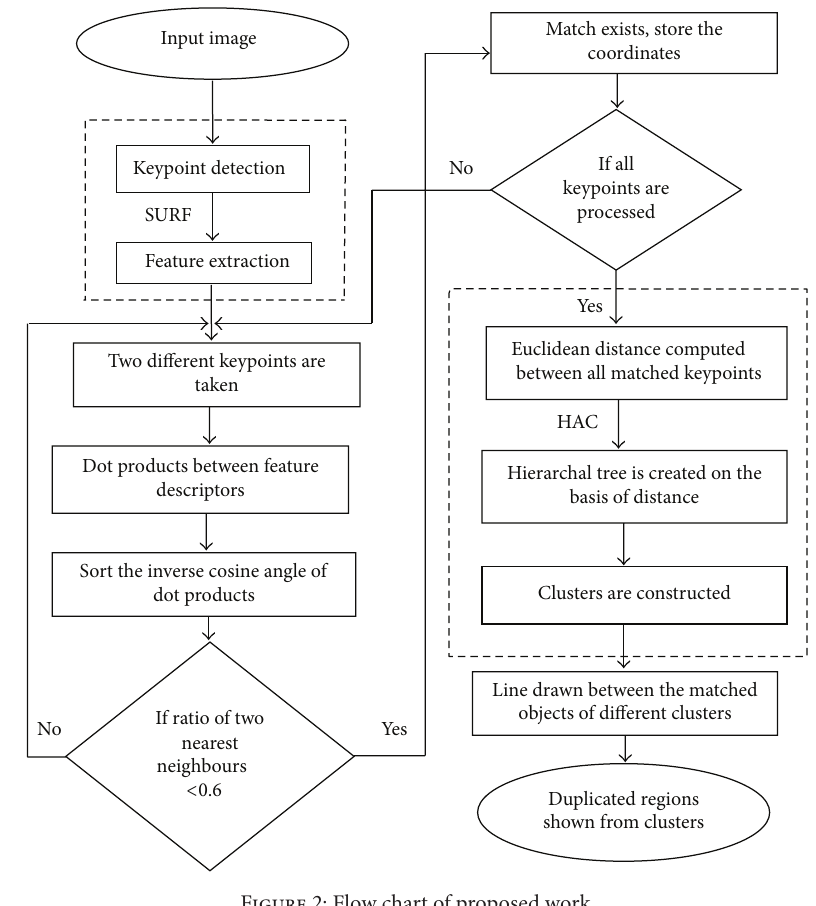
Figure 2: Flow chart of proposed work.